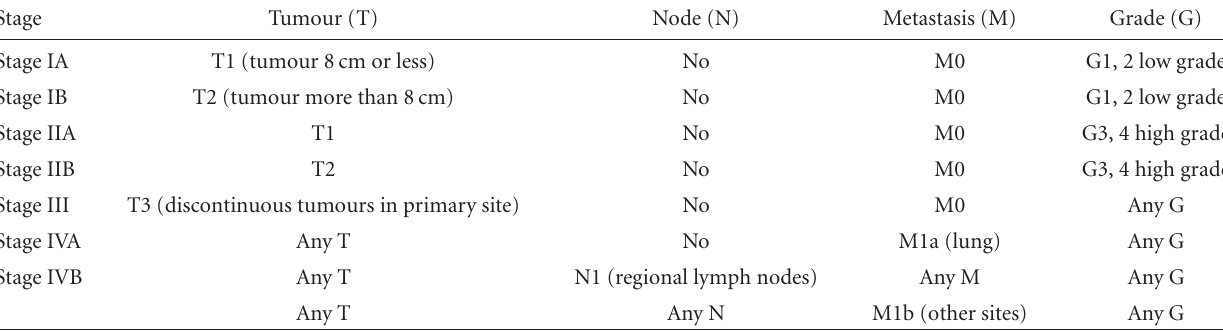
Table 3: AJCC/UICC